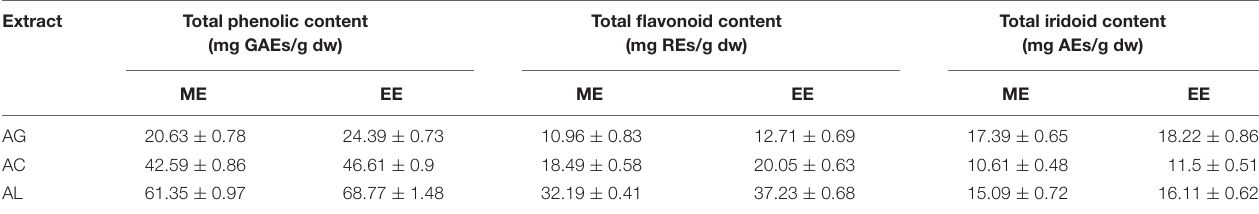
Data are shown as mean ± SD of triplicate